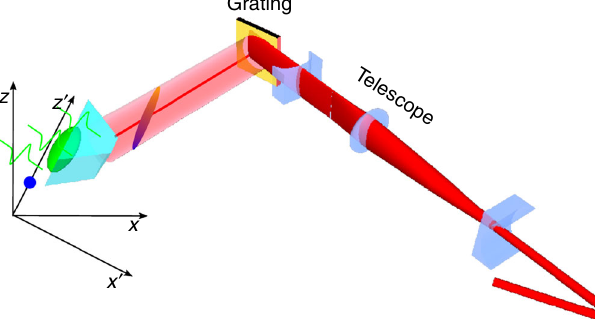
Fig. 7 Schematic arrangement for matching the transverse laser pro fi le to a travelling source geometry in LiNbO 3 . The cylindrical lens telescope shapes the laser transverse pro fi le to an elongated elliptical beam on the LiNbO 3 emission surface. The LiNbO 3 crystal is rotated with respect to the diffraction plane of the grating to provide components of the pulse-front tilt in both the Cherenkov phase-matching and travelling source directions. For clarity optical elements between the diffraction grating and crystal are not